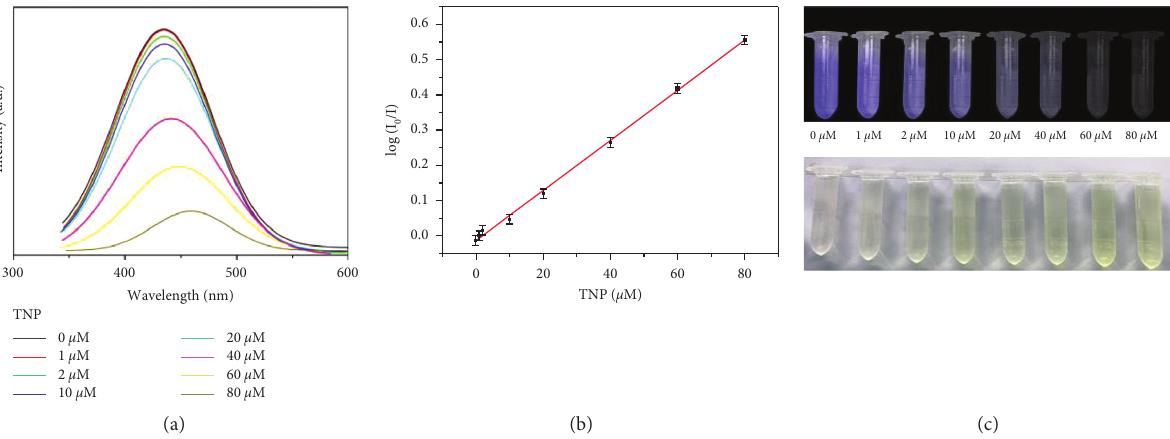
Figure 5: (a) Fluorescence emission spectra of CDs added with different concentrations of TNP. (b) Relationship between relative fluorescence intensity (log I 0 / I ) ( I 0 and I represent the fluorescence intensity of CDs in the absence and presence of TNP, respectively) and different concentrations of TNP. (c) Changes in fluorescence under UV light and visible to the naked eye after the addition of different concentrations of TNP. Table 1: Comparison of different methods for the determination of TNP.